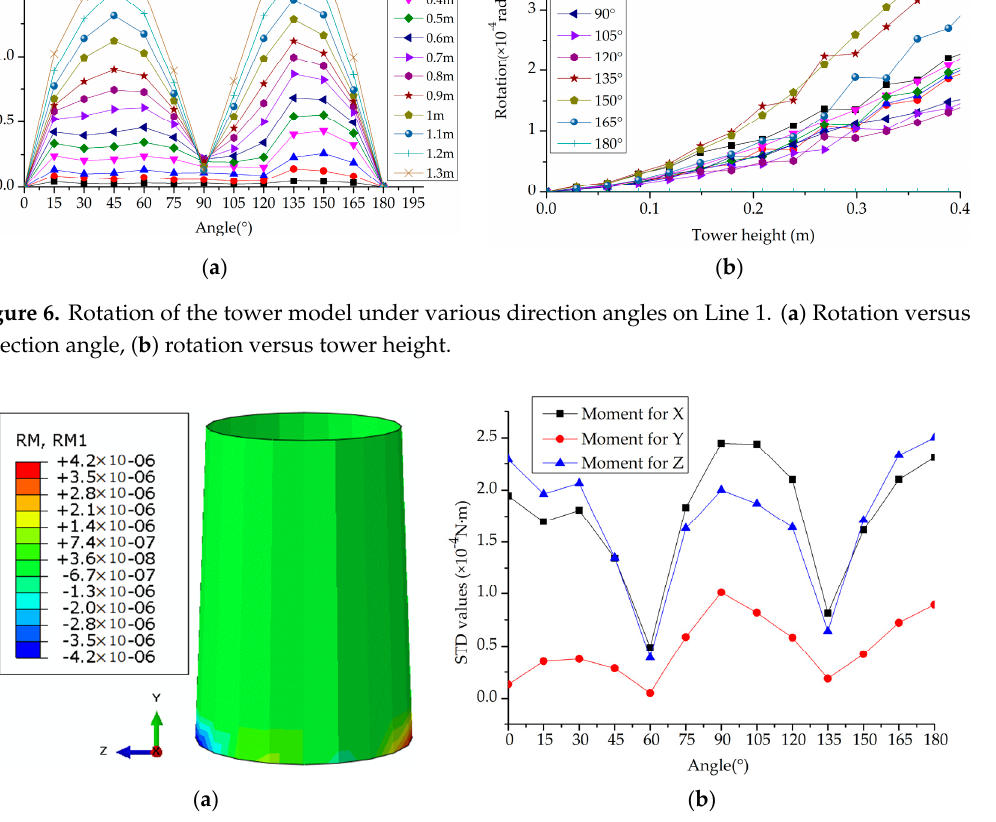
Figure 7. Reaction moment of tower base. ( a ) Contour of reaction moment (in N·m), ( b ) Standard deviation values versus direction angles.